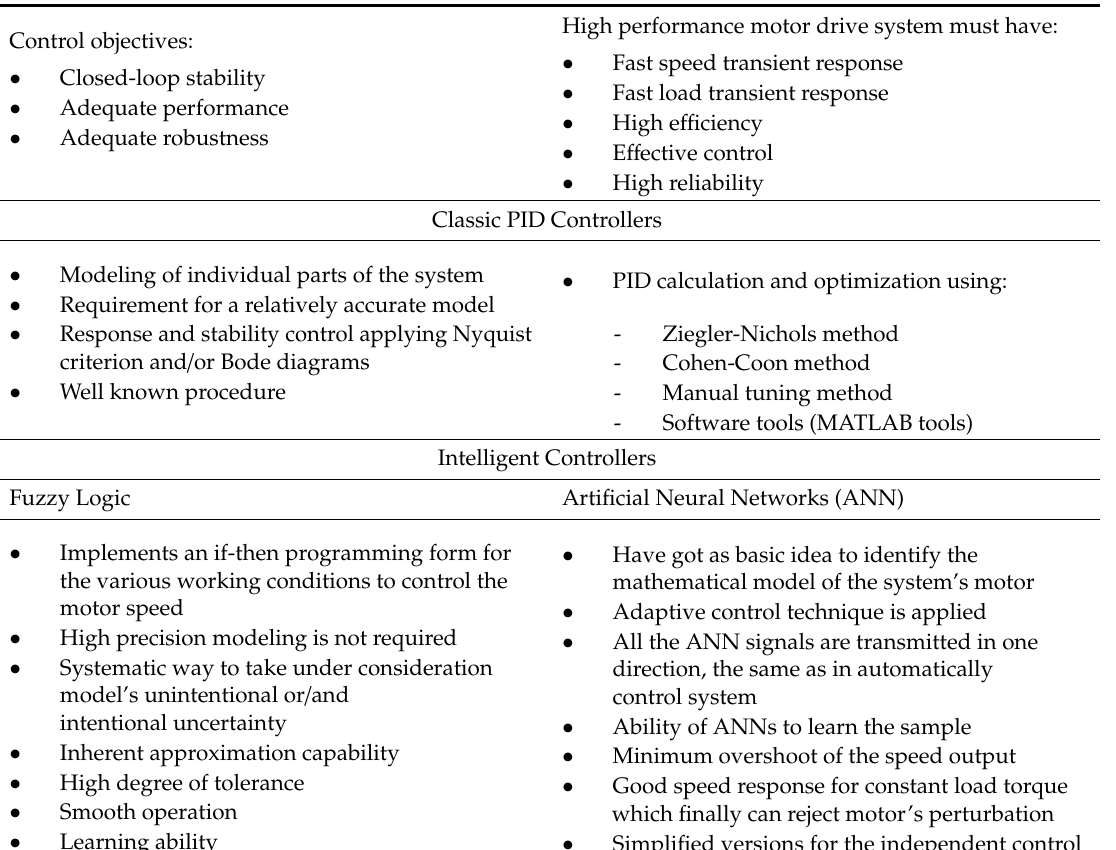
Figure 23. Basic ANN-training structure consisted of 3 layers [45]. Table 3. Control techniques for brushed DC motors